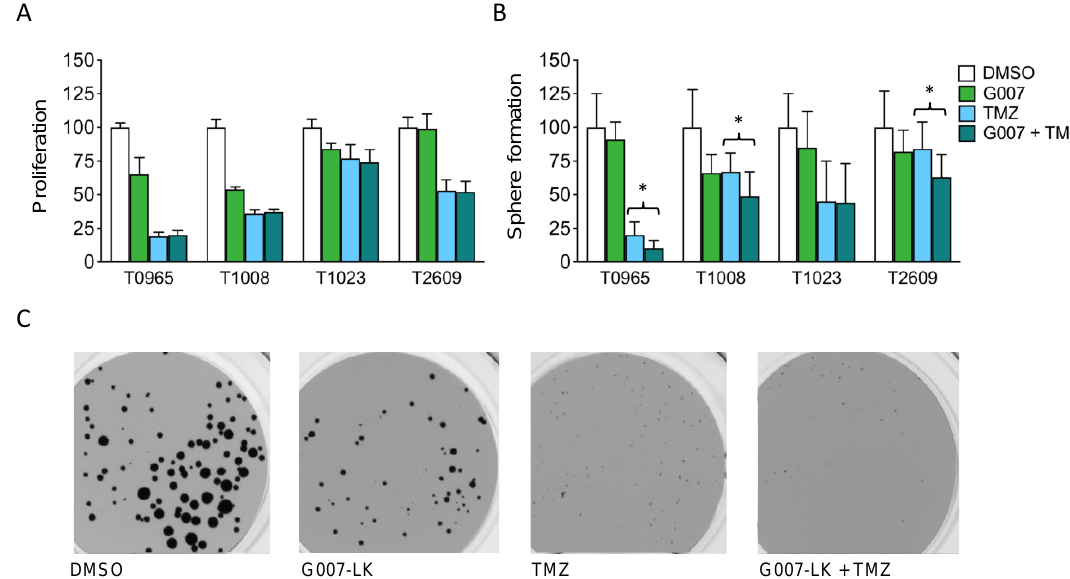
Figure 5. Cotreatment with temozolomide reduces the sphere-forming capacity of primary GSC cultures. ( A ) Proliferation of GSCs treated with temozolomide (TMZ) or with G007-LK / TMZ cotreatment; ( B ) Sphere formation by GSCs treated with TMZ or with G007-LK / TMZ cotreatment; ( C ) Images of T0965 spheres after 14 days of treatment. TMZ: 100 µ M; G007: 500 nM; G007-LK / TMZ cotreatment: 500 nM G007-LK + 100 µ M TMZ. Proliferation was measured by XTT assays and sphere formation as the total number of spheres formed in sphere formation assays, both after 14 days of treatment. Values are expressed as percentages relative to the DMSO (0.2%) control. The results are presented as the mean ± SD. * p < 0.05.